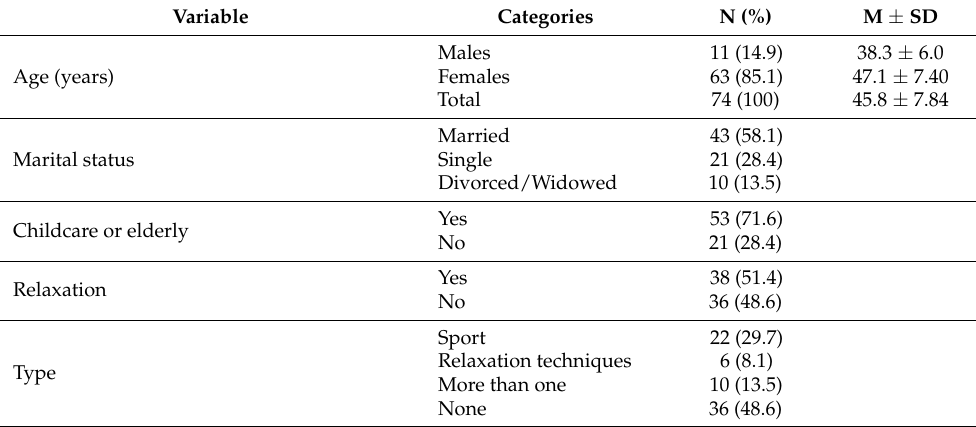
Table 1. Sociodemographic data and characteristics of the